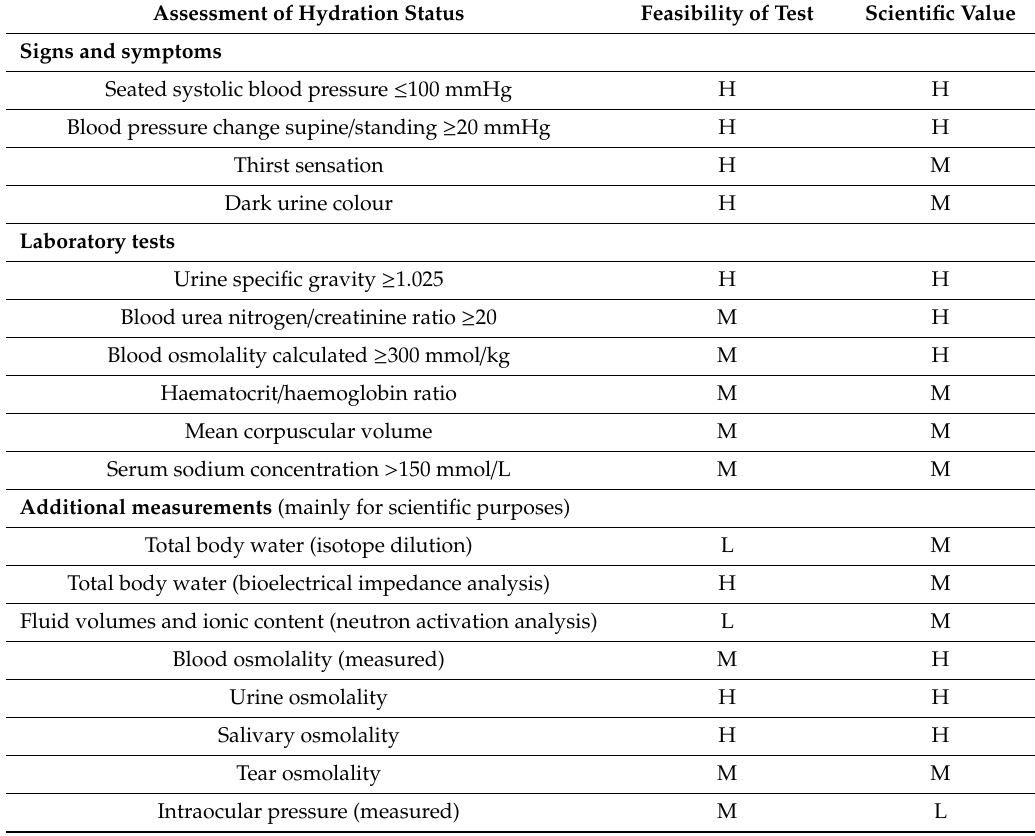
Table 2. Single signs, symptoms, and laboratory tests to identify dehydration